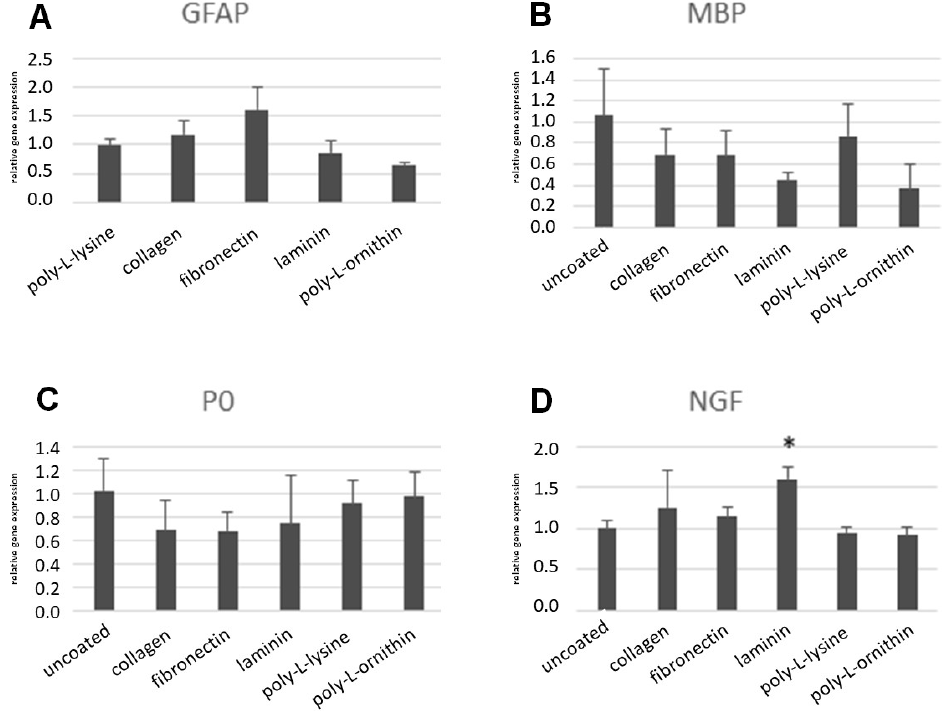
Figure 5. Comparison of marker gene expressions with qRT-PCR after differentiation on coated surfaces. ( A ) Expression of GFAP after differentiation with Protocol 1. ( B , C ) Expressions of MBP and P0 after differentiation with Protocol 2. ( D ) Expression of NGF after differentiation with Protocol 3. *: p -value < 0.05.